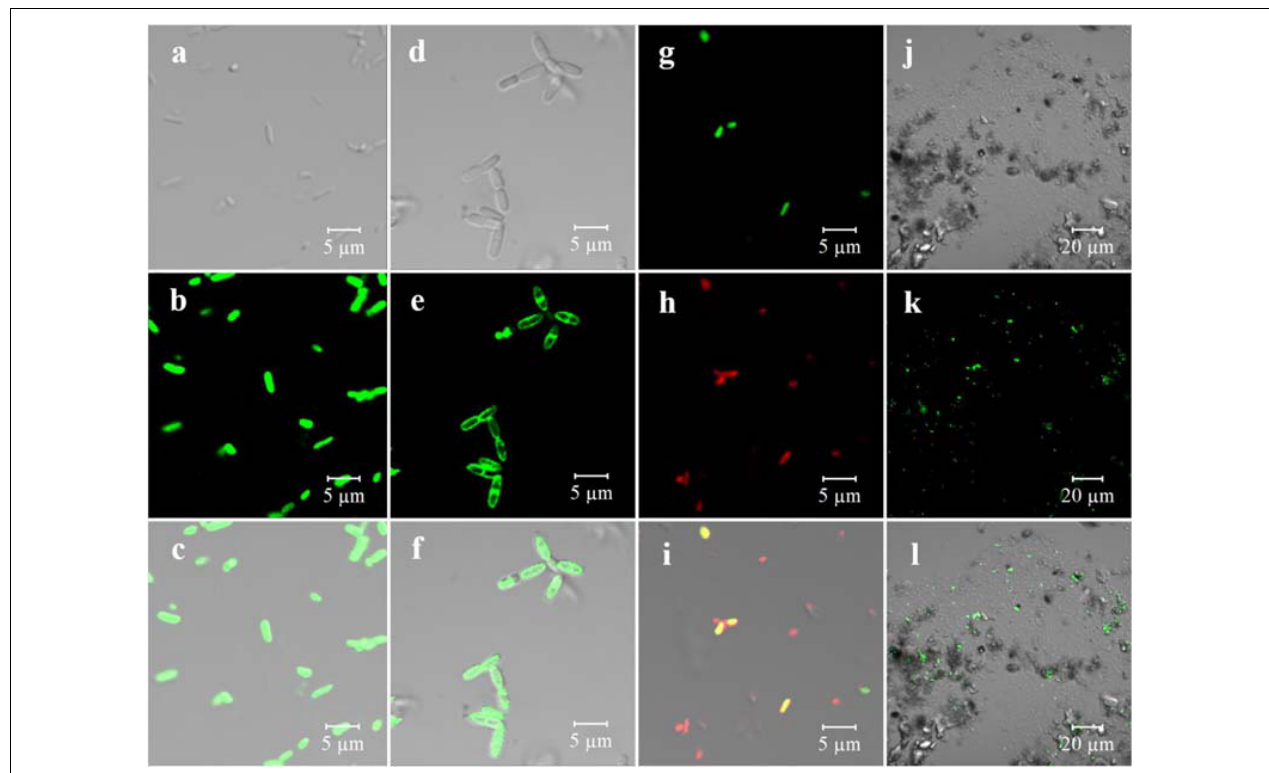
FIGURE 3 | Bioimaging of pure culture of microorganism and real samples with GQDs-M (1 mg/mL) including fluorescent channel, bright-field, and merged channel. (a) S12-bright field; (b) S12-GQDs-M channel; (C) S12-merged channel; (d) BI-42-bright field; (e) BI-42-GQDs-M channel; (f) BI-42-merged channel; (g) artificial microbial community (S12, Escherichia coli , C1)-GQDs-M channel; (h) artificial microbial community-DAPI channel; (i) artificial microbial community-merged channel; (j) environmental sample (Baihua Chong)-bright field; (k) environmental sample-GQDs-M channel; and (l) environmental sample-merged